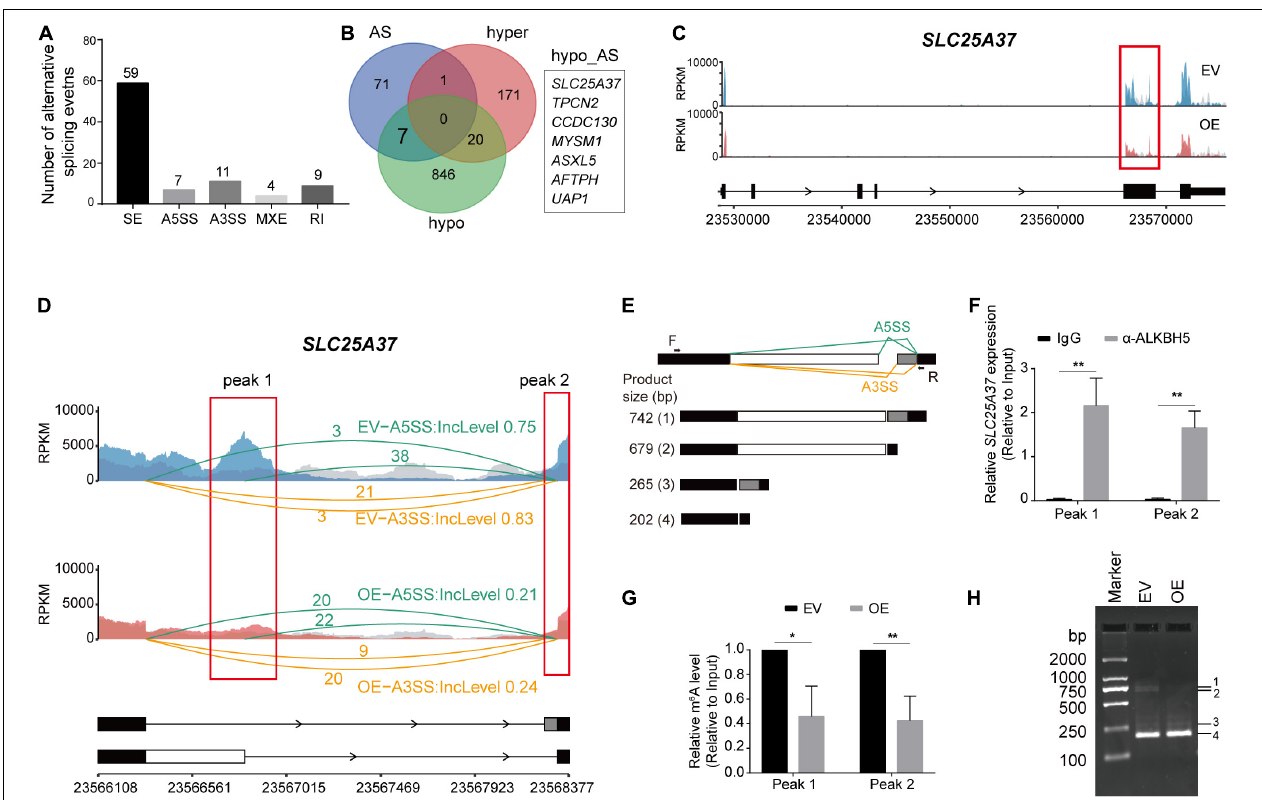
FIGURE 5 | ALKBH5 regulates the alternative splicing events of SLC25A37 RNA. (A) Statistics of the five types of alternative splicing events that are identified as significantly different in OE sample compared with EV sample. The differential alternative splicing events (FDR < 0.05) are identified by rMATS . (B) Venn plot exhibiting the intersects among the RNAs with hyper-, hypo-methylation peaks or differential alternative splicing events in OE sample. (C) Sequencing read density for input and m 6 A-IP samples along SLC25A37 transcript. (D) Zoom-in of the hypo-methylated region on SLC25A37 transcript. Sequencing read density of input and m 6 A-IP libraries along with exon junction read number were indicated. Inclusion levels of A3SS and A5SS events in both samples are recorded. Two concrete m 6 A peaks (Peak 1 and Peak 2) intersecting with alternative splicing sites are marked with red rectangles. (E) Diagram showing the alternative splicing formats of A5SS and A3SS on SLC25A28 transcript. Black arrows denote the position of PCR primers. Below the figure exhibiting different splicing variants and their molecular weights of PCR products. (F) RIP-qPCR results showing the interaction between ALKBH5 protein and SCL25A37 RNA at the two indicated regions in MIA PaCa-2 cells. (G) Results of m 6 A-RIP-qPCR showing the methylation changes at the two indicated regions between EV and OE samples. (H) PCR results showing the size and quantity of four types of transcripts in ALKBH5-overexpressing and control cells. * P < 0.05, ** P <